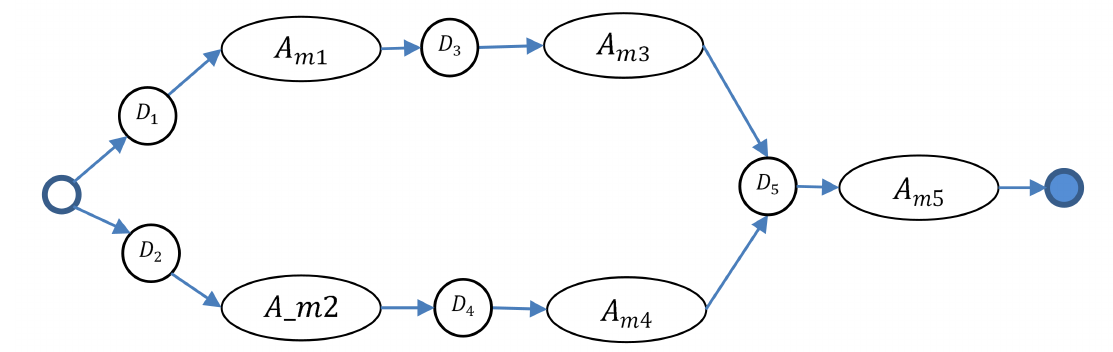
Figure 3. An example of a technological operation network with